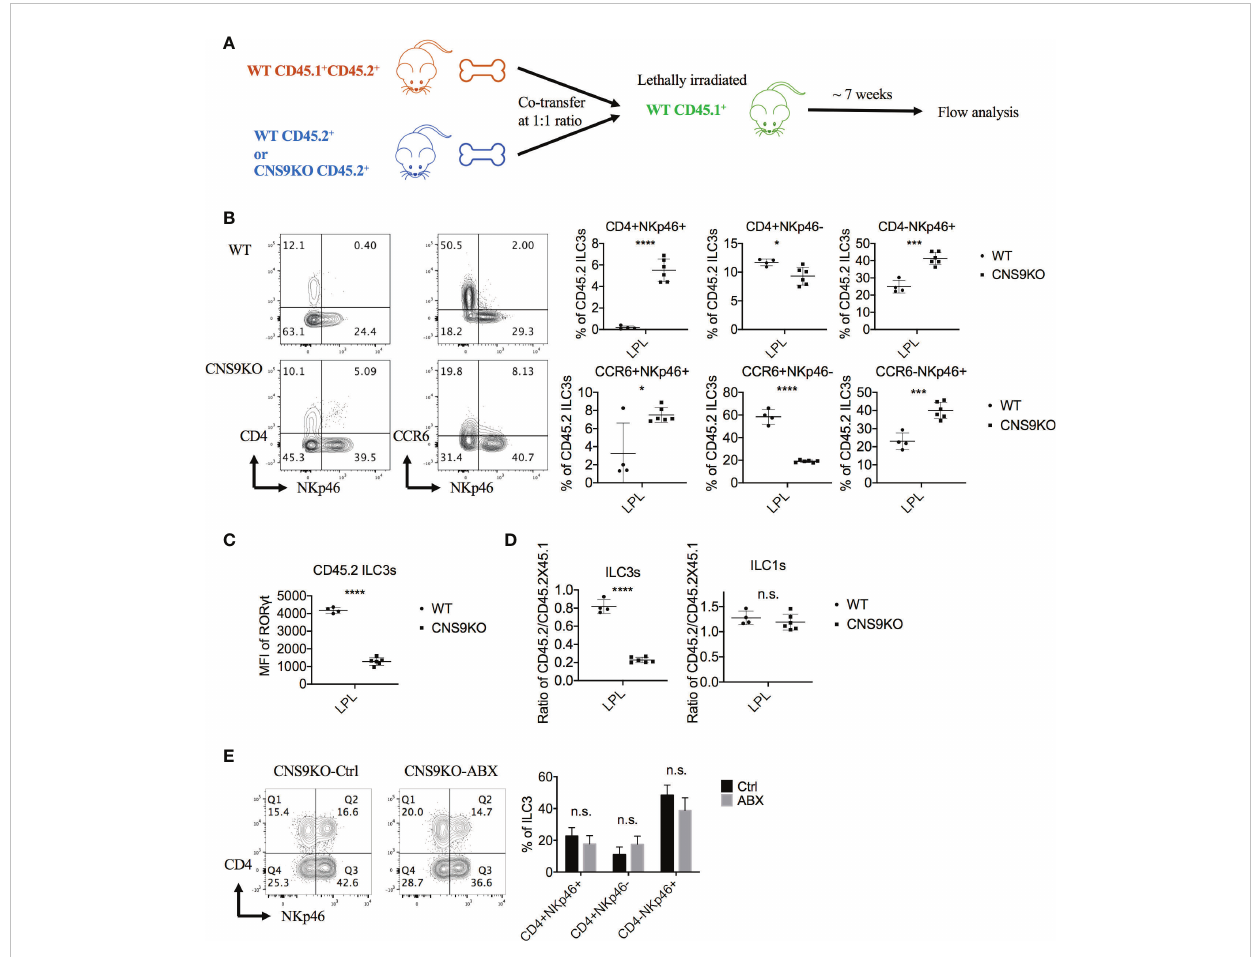
FIGURE 3 CNS9 de fi ciency promotes the generation of CD4 + NKp46 + ILC3 subset via a cell-intrinsic manner. (A) Experiment protocol: The CD45.1 + CD45.2 + WT BM cells and CD45.2 + CNS9-dei fi ent BM cells were transferred to irradiated CD45.1 + mice at a 1:1 ratio. Seven weeks later, the recipient mice were saci fi ced and the small intestine LPLs were collected and analyzed by fl ow cytometry. (B) The ILC3s were gated as Live CD3 - CD90 + ROR g t + CD45.2 + cells. Left: surface staining of CD4, NKp46, CCR6 of ILC3s; right: statistic of the staining data. (C) MFI of ROR g t in CD45.2 + WT and CNS9-de fi cient ILC3s. (D) The ratios of CD45.2 + WT/CNS9-de fi cient versus CD45.1 + CD45.2 + WT ILC3s or ILC1s. The data shown are a representative of